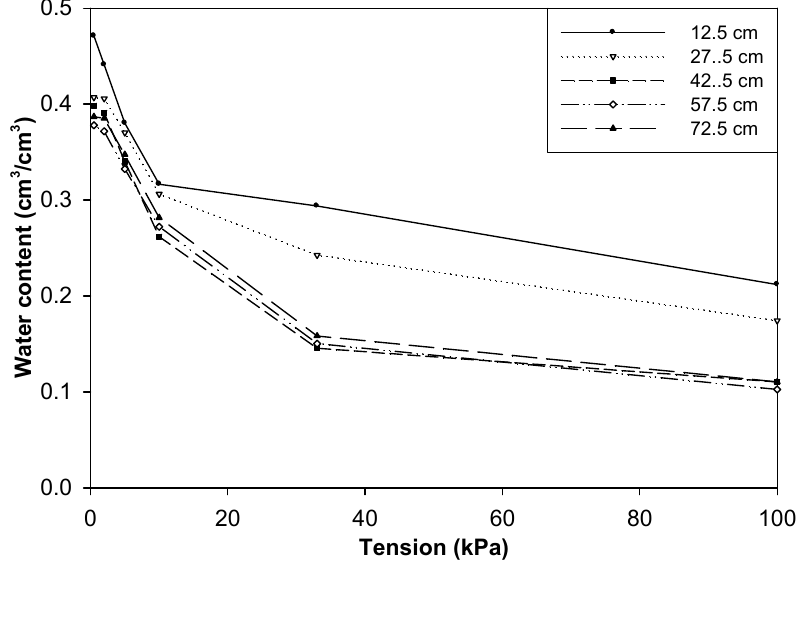
Figure 1. Partial soil water retention characteristic curves for different soil layers from the surface shown at the mid-point depth of the core. (a) 12.5 cm, (b) 27.5 cm, (c) 42.5 cm, (d) 57.5 cm, and (e) 72.5